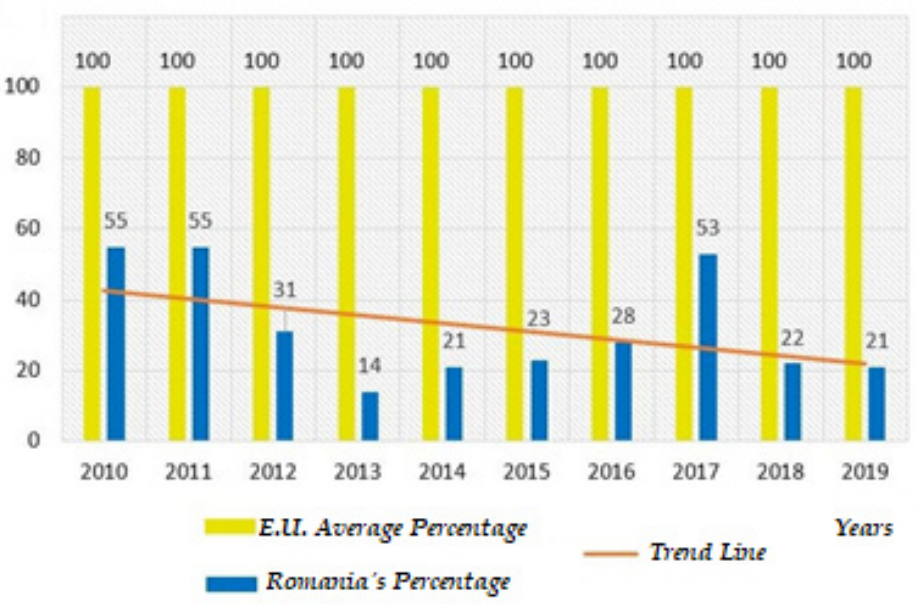
Figure 2. General indicators in the eco-innovation field versus Romania [10] (Authors’ own source).